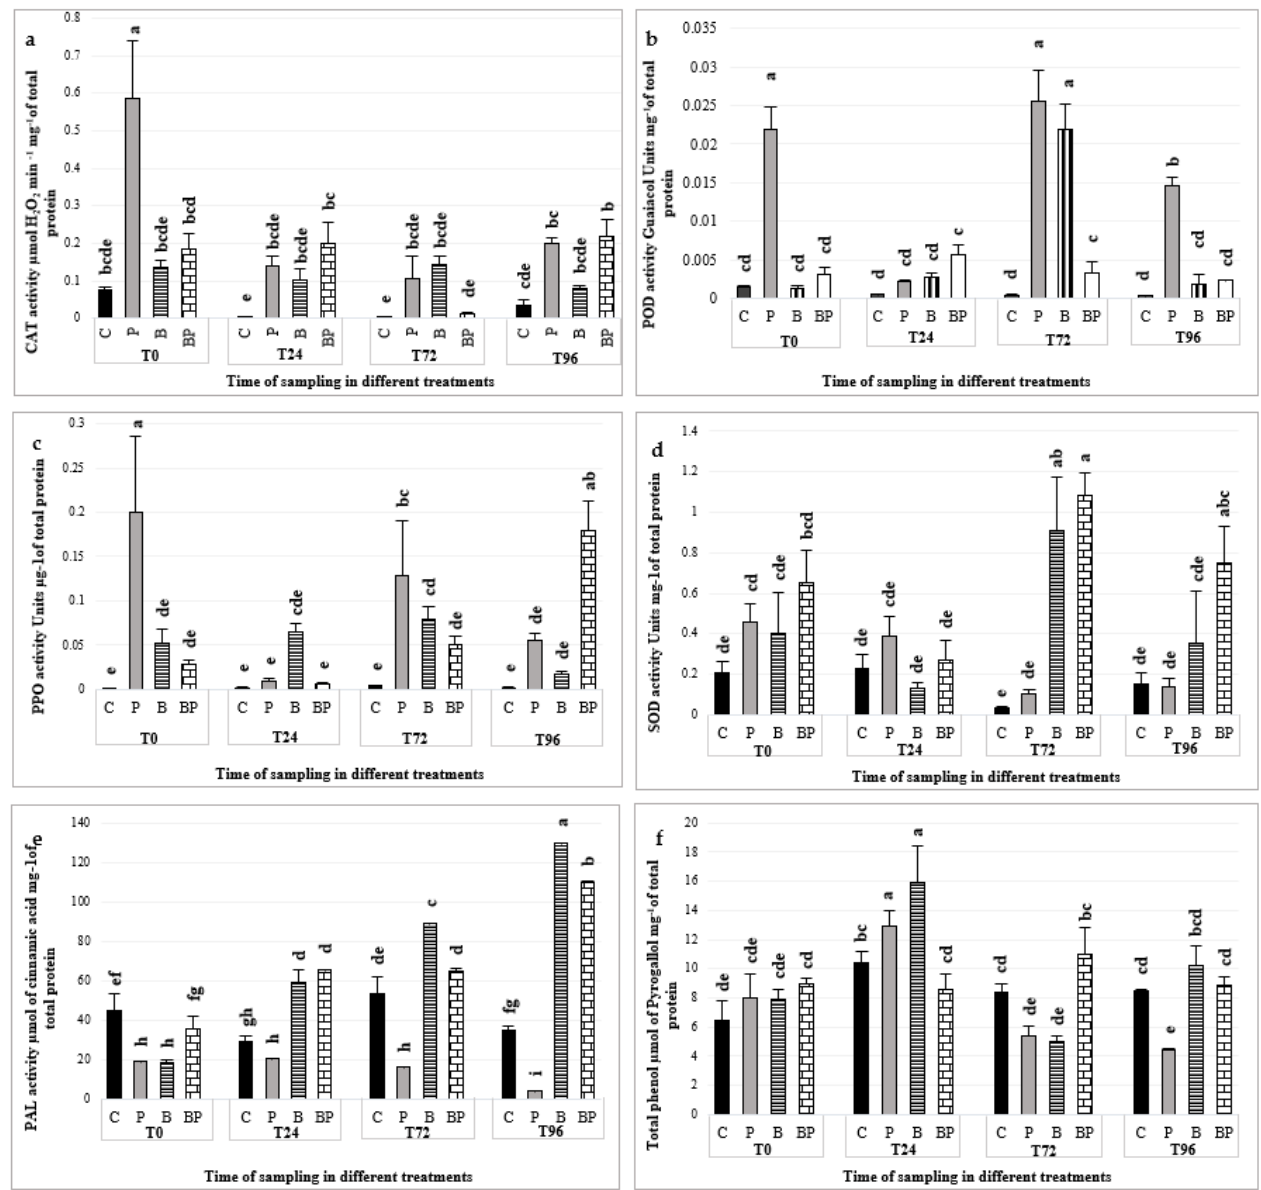
Figure 1. Activity of some defense-related enzymes in response to prodigiosin produced by S. rubidaea analyzed in mock-treated control fruits (C); + B. cinerea inoculated fruits (P); +prodigiosin inoculated on fruits (B); and +prodigiosin inoculated on fruits + B. cinerea treated plants (BP), at 0, 24, 72 and 96 h after B. cinerea infection. The bars are the mean activities of the defense-related enzymes CAT ( a ), POD ( b ), PPO ( c ), SOD ( d ), PAL ( e ) and total phenol ( f ) calculated on three replicates. Mean followed by different letters represents significant differences according to the LSD test ( α = 0.05).